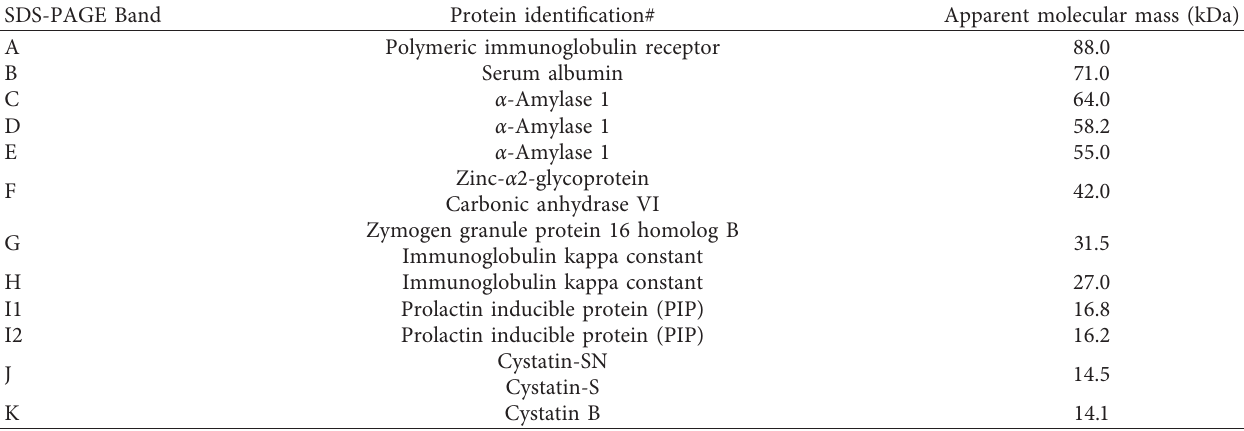
Table 3: Proteins present in the bands observed in SDS-PAGE salivary profiles.